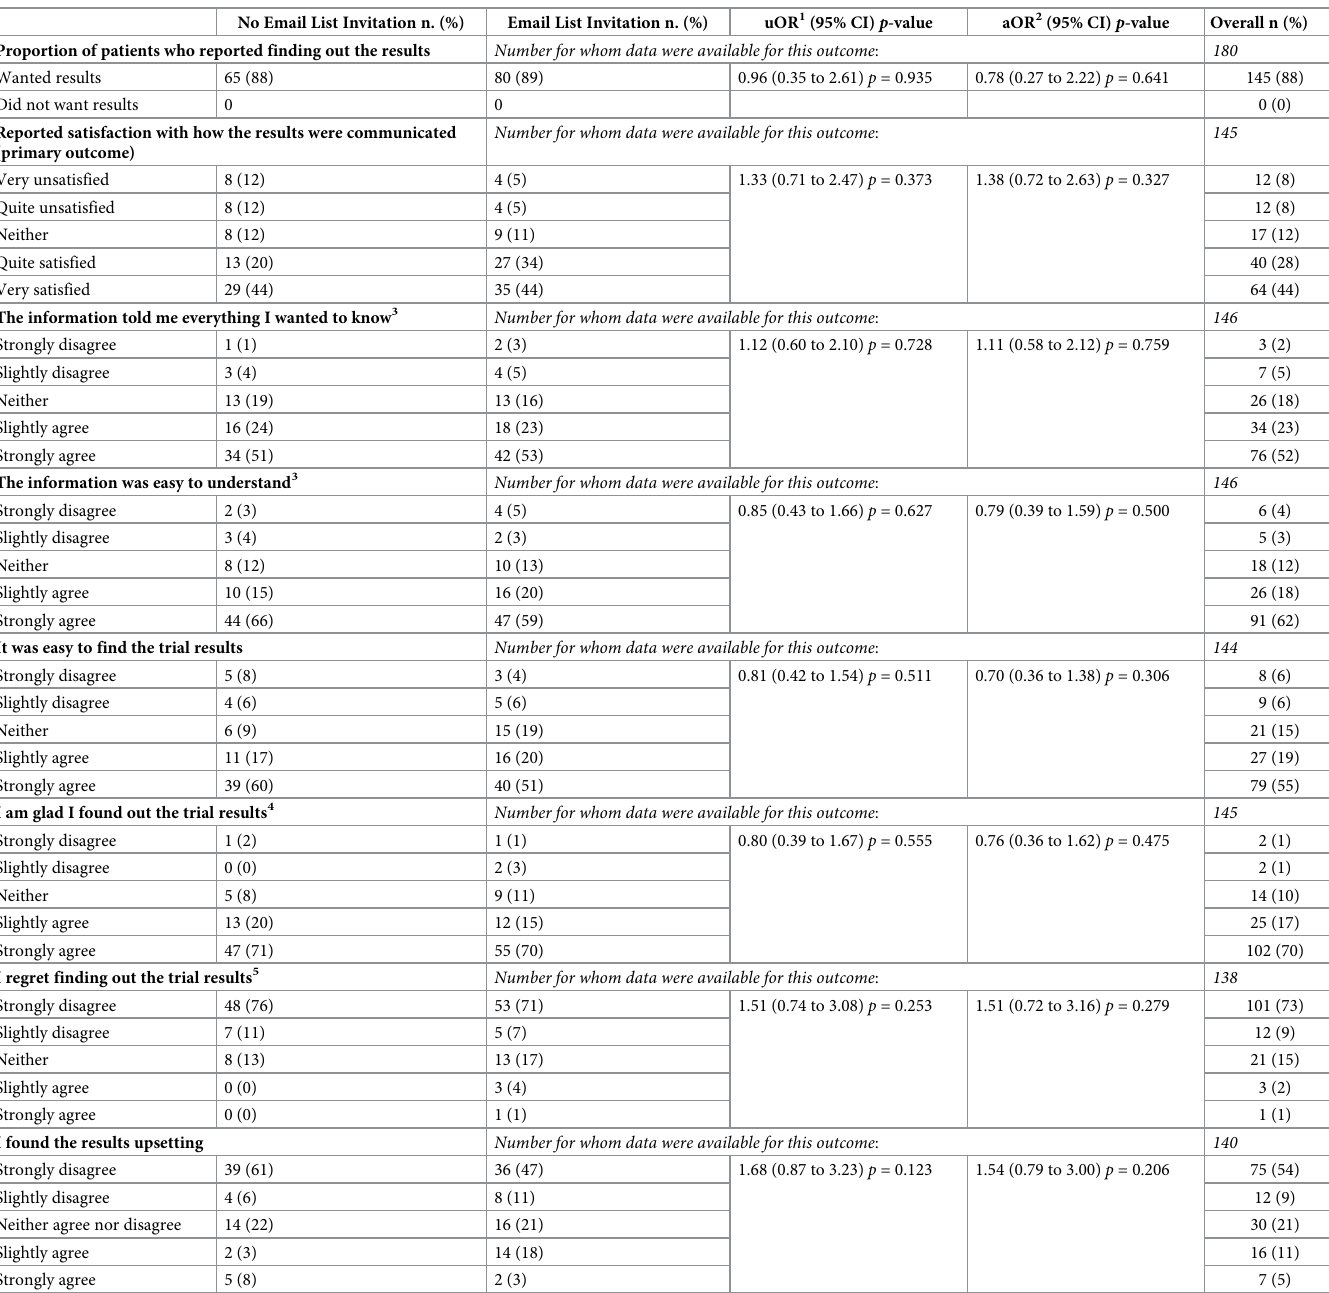
Table 6. Reported outcomes relating to experience of receiving the results by randomised intervention: Email List Invitation versus no Email List Invitation. No Email List Invitation n. (%) Email List Invitation n. (%) uOR 1 (95% CI) p -value aOR 2 (95% CI) p -value Overall n